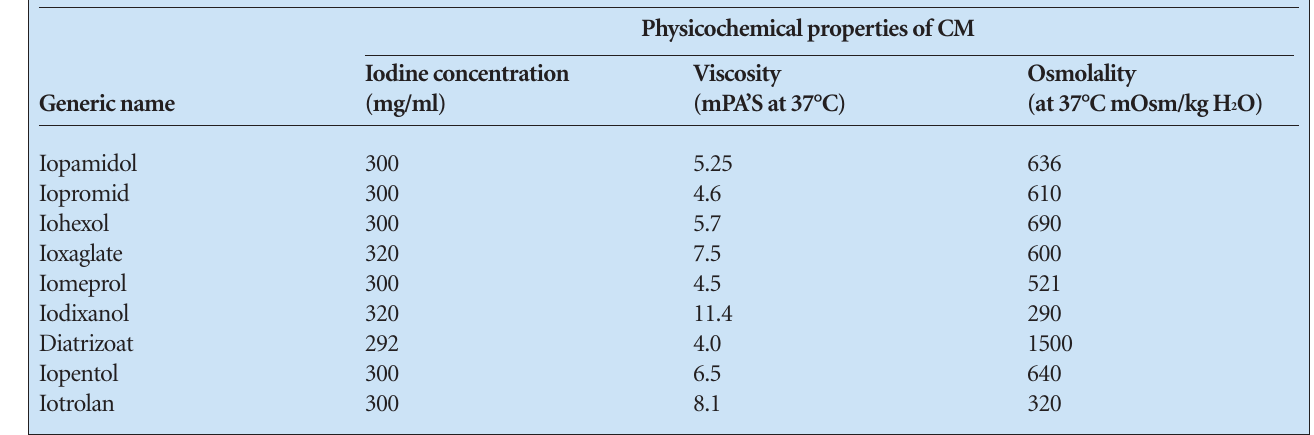
Table I. Osmolality and viscosity for various CMs.Note differences in iodine